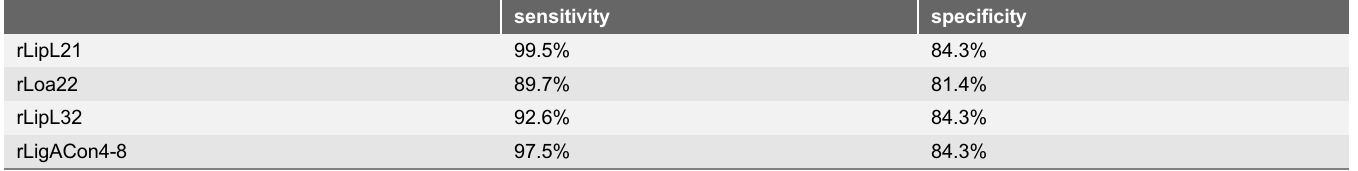
Table 2. Sensitivity and specificity of the ELISA test when a single protein was evaluated in comparison to the MAT result.